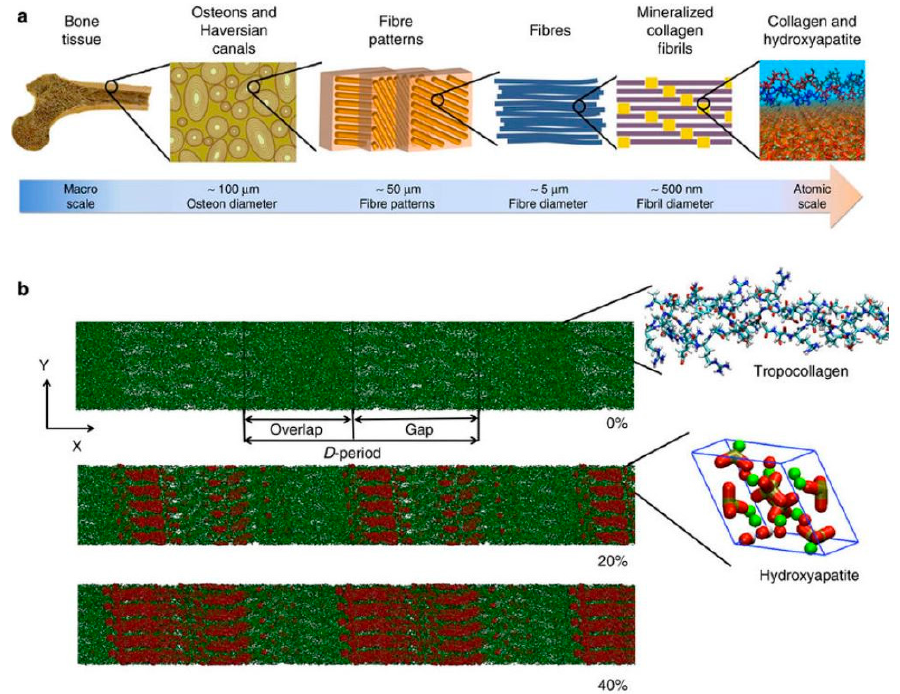
Figure 3. Organization of collagen and hydroxyapatite (HAP) in bone. ( a ) Hierarchical structure of bone ranging from the macroscale skeleton to nanoscale collagen (green) and HAP (red). ( b ) Collagen microfibril model with 0% mineralization (inset shows the collagen triple-helix structure), 20% mineral content (inset shows a HAP unit cell) and 40% mineral content. The HAP crystals are arranged such that the c axis of crystal aligns with the fibril axis. Ca atoms plotted in green, OH groups plotted in red and white, and the tetrahedron structure visualizes the PO4 group. Permission obtained from Springer Nature. © Nair, A.K. et al., Nat Commun . 4: p. 1724. (2013). [100].